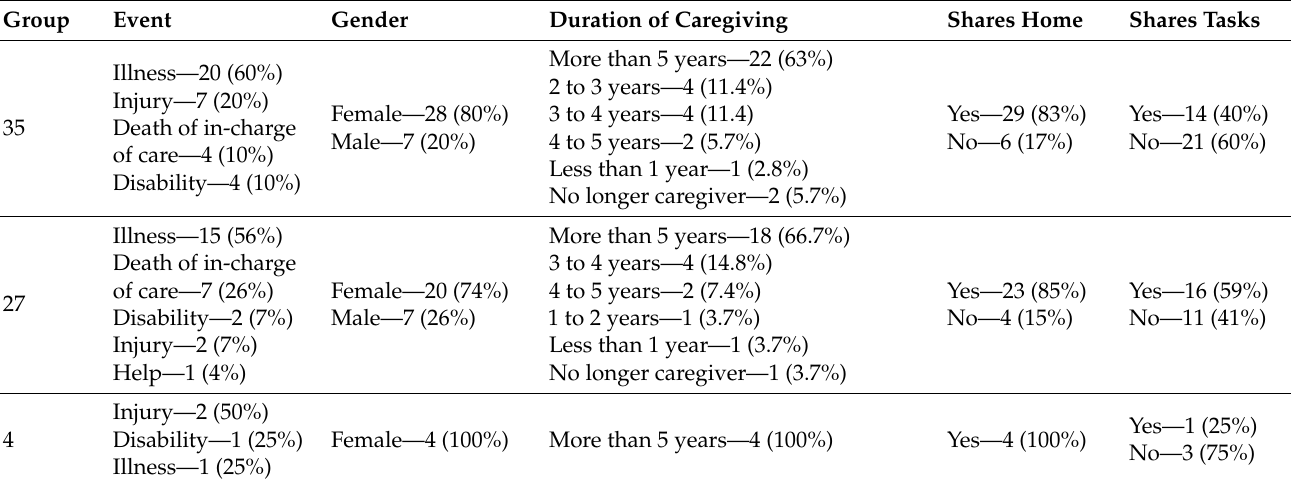
Table 4. Demographics of Groups 35, 27, and